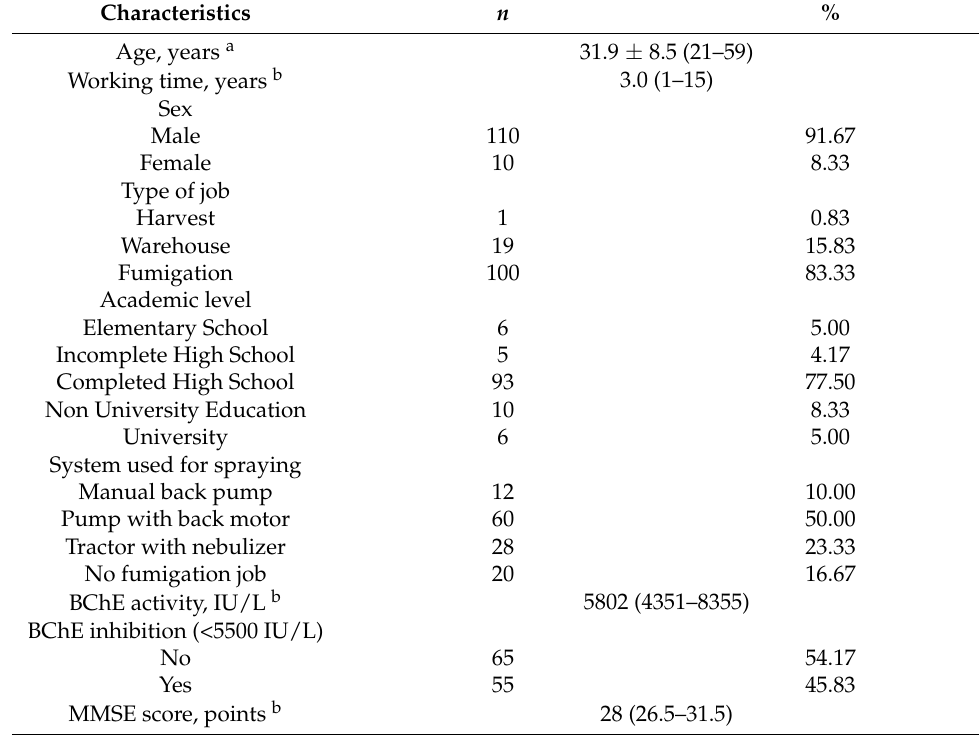
Table 1. Descriptive characteristics of the study participants ( n = 120).